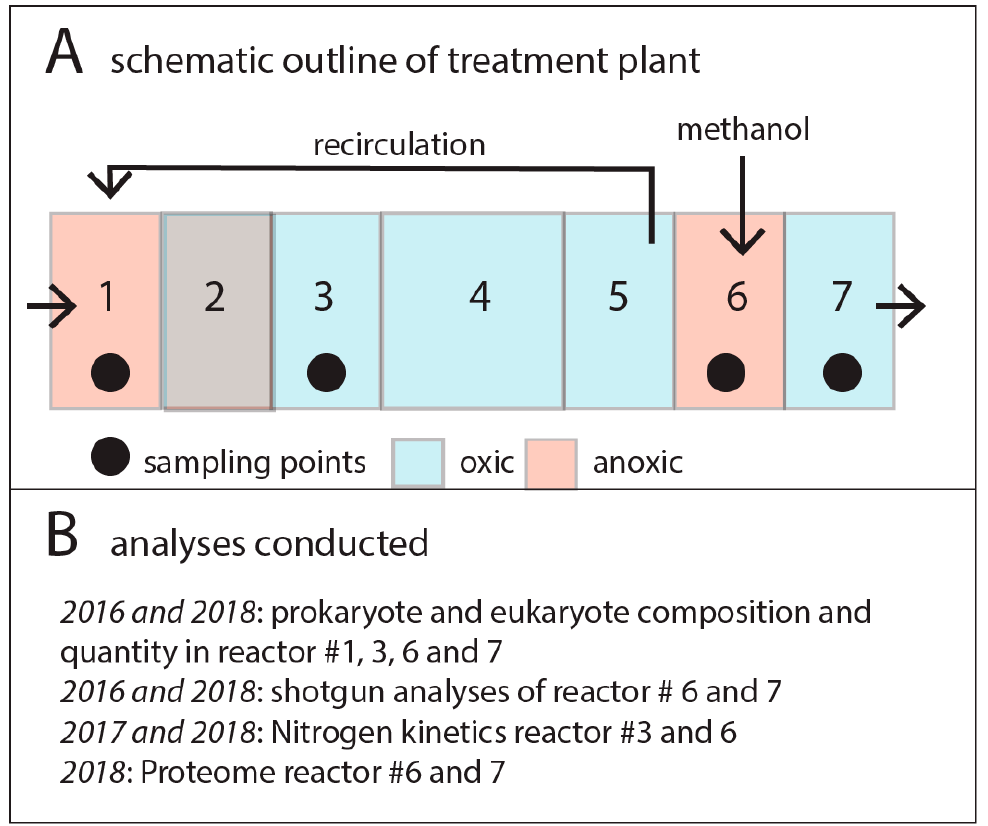
Figure 1. Schematic outline of ( A ) the nitrogen-removal plant, and ( B ) the analyses conducted. ( A ) The plant consisted of 7 reactors, where Reactor #2 was switched between oxic and anoxic conditions (oxic during winter and anoxic during summer). ( B ) Summary of the analyses conducted for the different years and reactors. Samplings for both 2016 and 2018 were done in March.